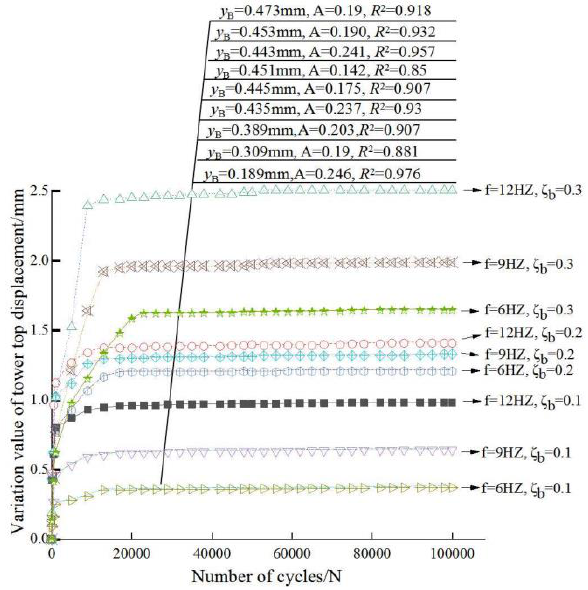
Figure 8. Variation of displacement at the mudline. Notes: The fitting data are consistent with the measured curves from top to bottom and no fitting curve is drawn.